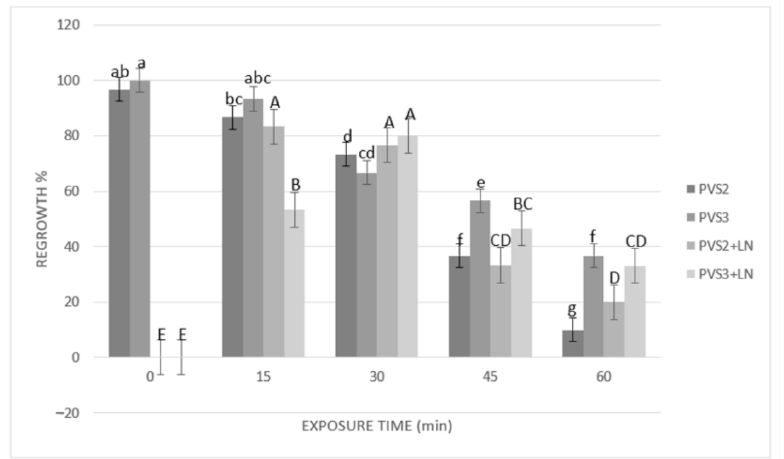
Figure 3. Effect of exposure length to plant vitrification solutions (PVS) PVS2 or PVS3 at 0 ◦ C on regrowth of somatic embryos (SEs) before and after cryopreservation. SEs were precultured on MS solid medium with 0.3 M sucrose in the dark for one day, encapsulated over the cryoplate with calcium alginate (2%) containing 0.4 M sucrose, and loaded with 1 M sucrose + 2 M glycerol for 15 min before exposure to PVS. Data are represented by means (%) ± standard error (se). Bars with the same letter are not significantly different p ≤ 0.05 (LSD test). Lowercase letters refer to non-cryopreserved controls, and uppercase letters refer to cryopreserved plus liquid nitrogen (+LN) samples. Regrowth was detected as the percentage of SEs that showed elongation of coleoptile and the formation of radicle 45 days after their transfer to the culture medium.